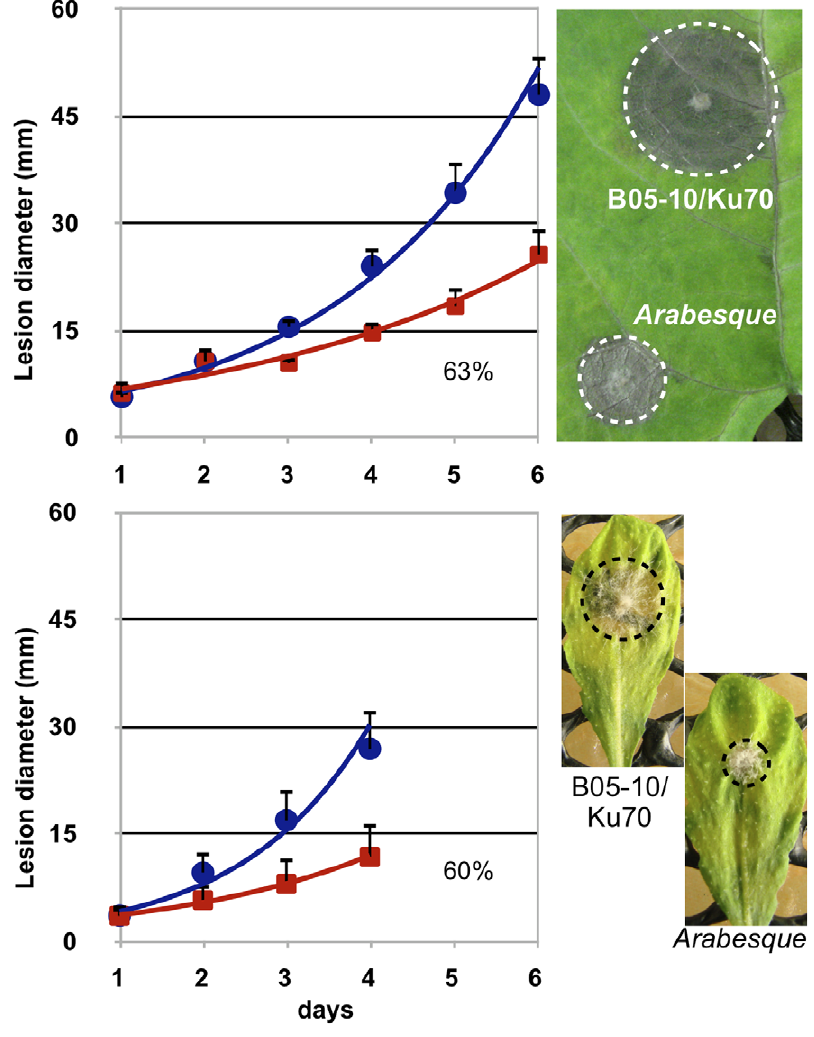
Figure 4. Impact of the BcHOX8 mutation on mycelium-derived infection. Kinetic of green bean (top) and thale cress (bottom) leaves infection by the parental B05-10/ D ku70 (circle) and the Arabesque mutant B05-T 70-1 (square) strains using 1.8 mm mycelium plugs as inoculum. In the case of green bean infection, 6 independent experiments using 6 leaves each (days 1 and 2) or 30 leaves each (days . 2) were performed. In the case of thale cress infection, 3 independent experiments using 6 leaves each were performed. Monitoring of thale cress infection stopped when the necrosis zone of the parent control reached the leaves edges. Linearization of the exponential curves allowed calculation of the relative mutant growth when compared to its parent (% of the slope obtained for the parental strain). 4-days infection pictures are shown.